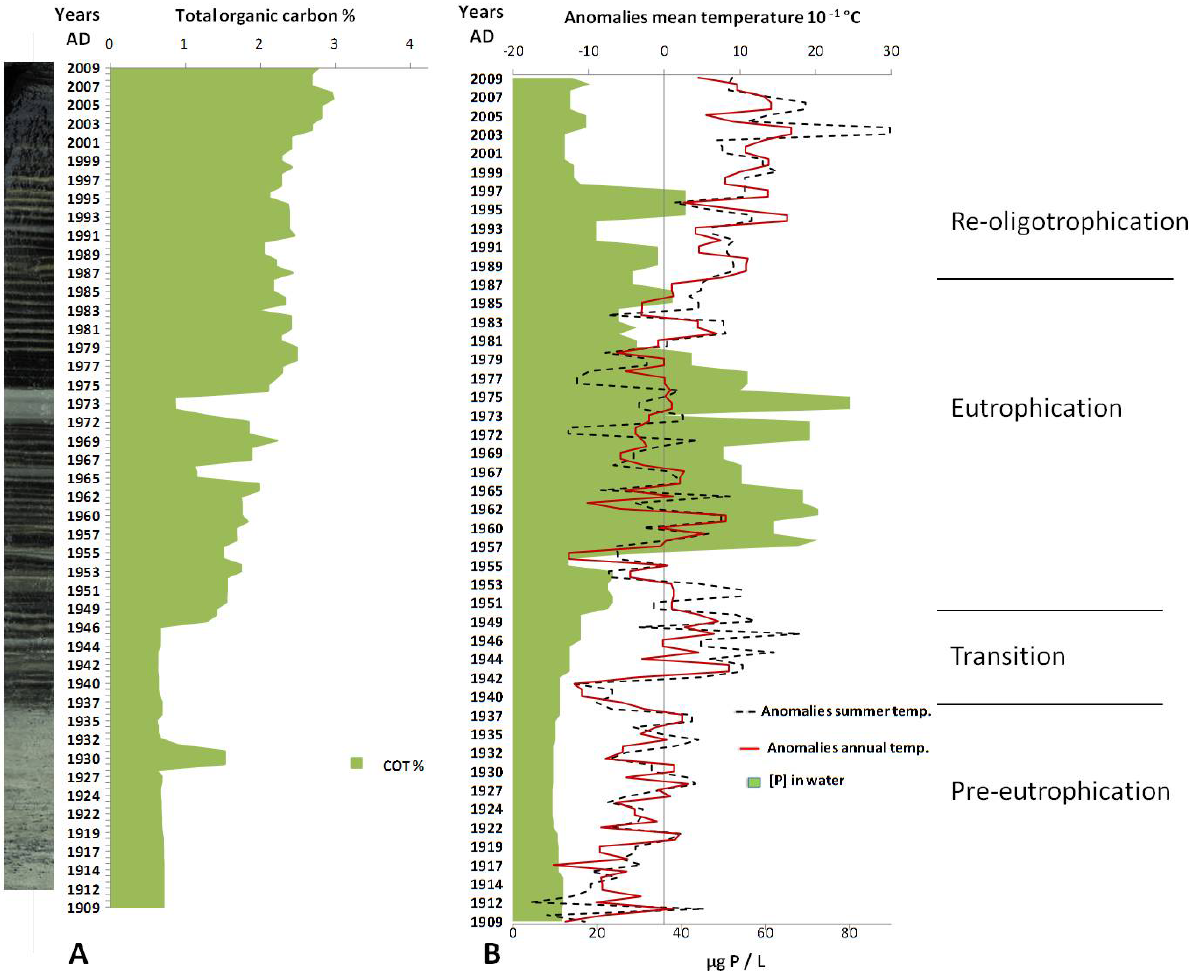
Fig. 1. Profile A presents the organic geochemistry diagram from sediment core: TOC (total organic carbon) in percent of dry sediment (1909–2009). A photograph of the core is provided. Profile B presents Phosphorus the concentration (in water) reconstructed over the study time using a diatom-transfer function; the evolution of temperature as revealed by anomalies to 20th century mean temperature; the annual average and the summer average (10 − 1 ◦ C) are